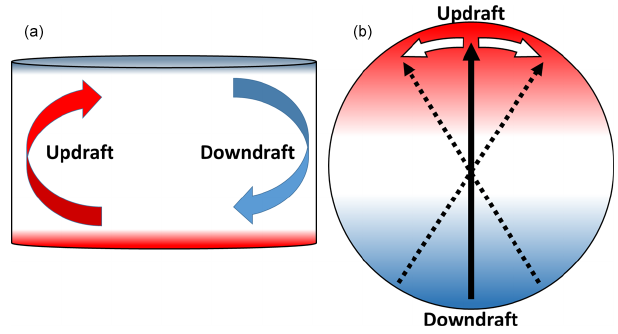
Figure 1. Cross section (a) and plan view (b) of the motion of the LSC in a cylindrical geometry of aspect ratio 2. (a) The arrows in- dicate the mean direction of the airflow due to the circulation with the red arrow describing the warm updraft and the blue arrow repre- senting the cool downdraft. (b) The black solid arrow points towards the updraft. The white arrows and dotted black arrows describe the azimuthal oscillations in the